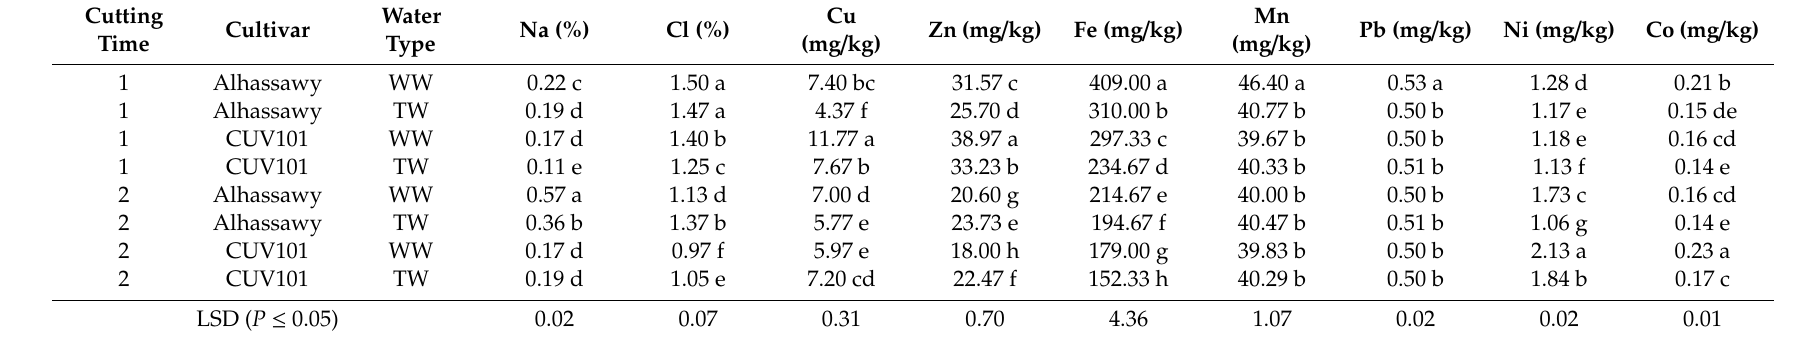
Table 8. E ff ect of the overall interaction between cutting time, cultivar, and water type on alfalfa micronutrient contents.